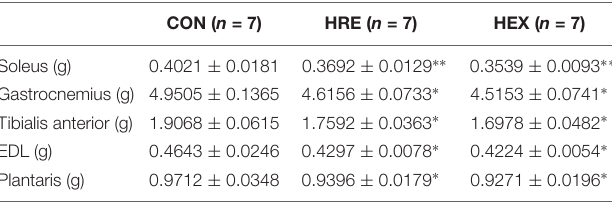
TABLE 4 | Recovery intervention-mediated skeletal muscles weight following hindlimb suspension. CON ( n =